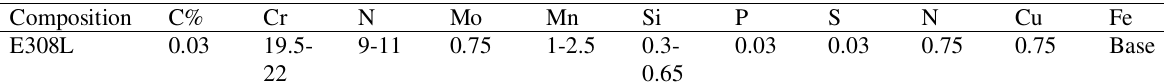
chemical contents of E308L filler metal used for this work.